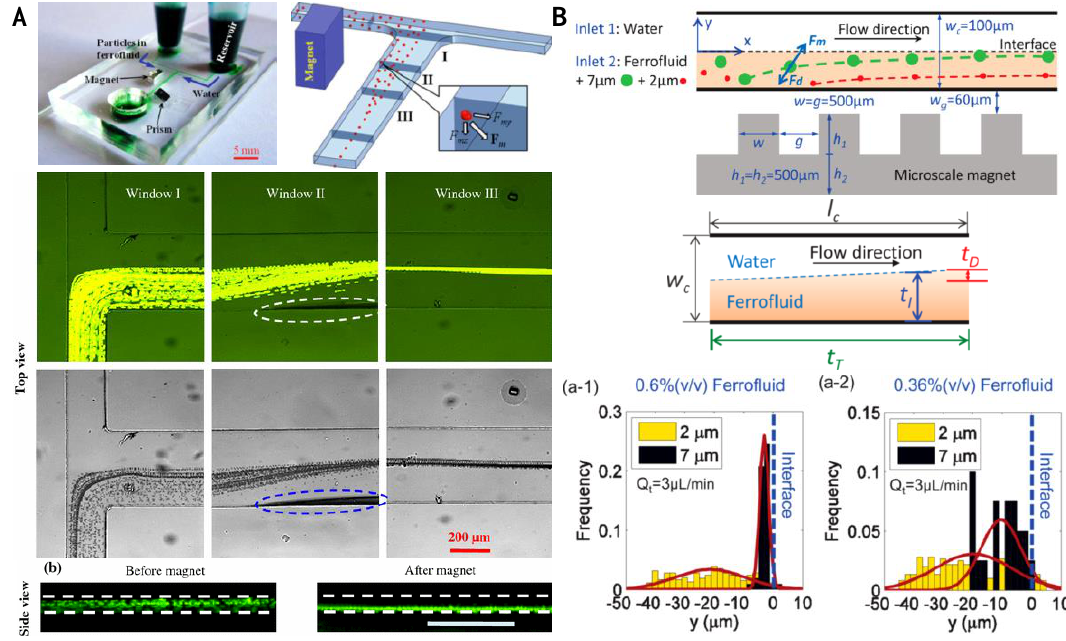
Figure 6. Sheath flow-assisted diamagnetic particle focusing in ferrofluid flows under the magnetic field of a single permanent magnet. ( A ) Picture of the microfluidic device and schematic illustration of the diamagnetic particle focusing mechanism in a T-shaped microchannel (top); top-view (both in fluorescent and bright field) and side-view images of the horizontal and vertical focusing of 5 µm diamagnetic beads in 0.01 × EMG 408 ferrofluid (bottom). Adapted with permission from Liang et al. [94], © 2012 Springer. ( B ) Enlarged view of the microchannel ferrofluid particle micro-magnet system (top) and illustration of the time scales for particle migration in a two-phase flow system (middle); plots for the Gaussian distribution of 2 µm and 7 µm diamagnetic beads at the channel outlet (bottom). Adapted with permission from Zhou and Wang [95], 2016 American Institute of Physics.